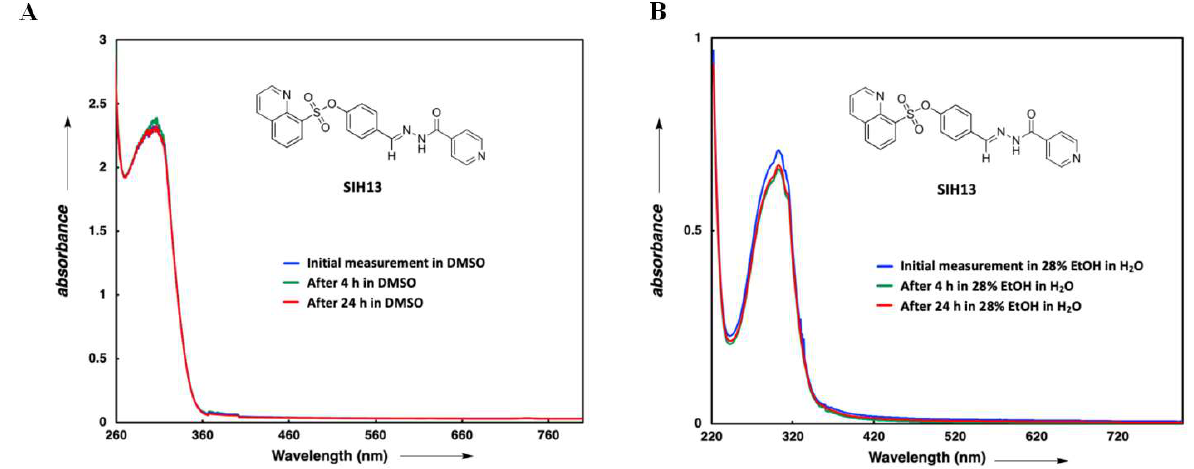
Figure 4. Stability assessment of SIH13 in DMSO ( A ) and ethanol-water mixture ( B ).